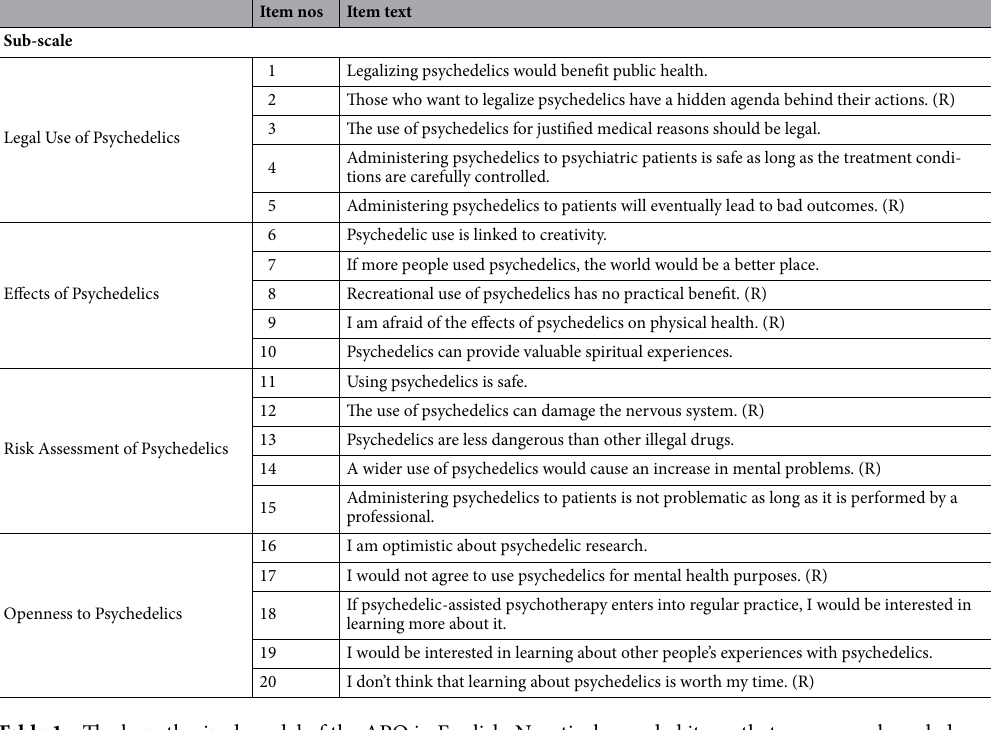
Table 1. The hypothesized model of the APQ in English. Negatively worded items that are reversely coded are marked by (R).